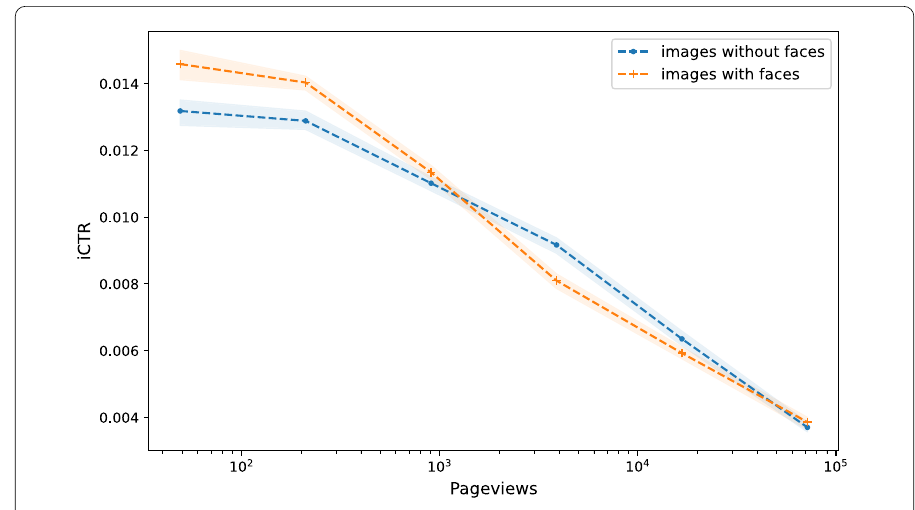
Figure 11 Comparison of the iCTR for images with faces (orange) and without faces (blue) as function of the popularity ( pageviews ). Error bands represent bootstrapped 95%